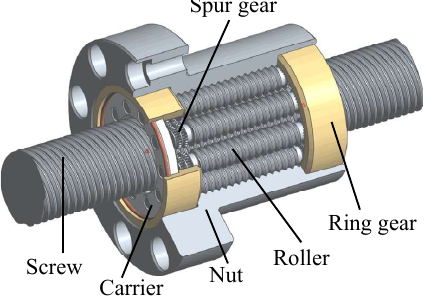
Figure 1. Structure of the standard planetary roller screw mechanism.